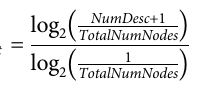
Frontiers in Research Metrics and Analytics |